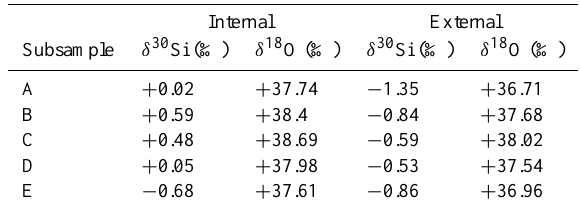
Table 1. Stable isotope results for DH19-2 Asbestopluma sp. speci-